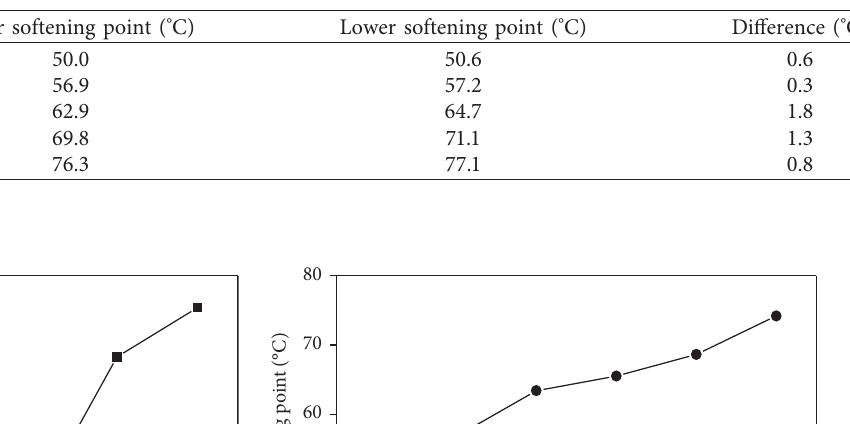
Table 7: Results of the segregation test.